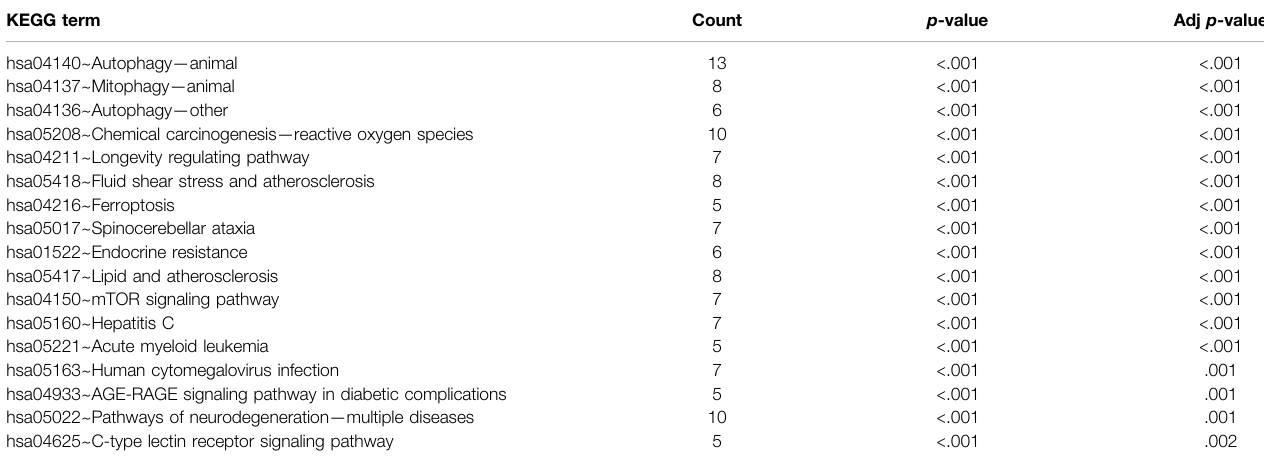
TABLE 7 | Signifcantly enriched KEGG terms of co-expression mRNA with PAAD with an adjusted p < .05 KEGG term Count p